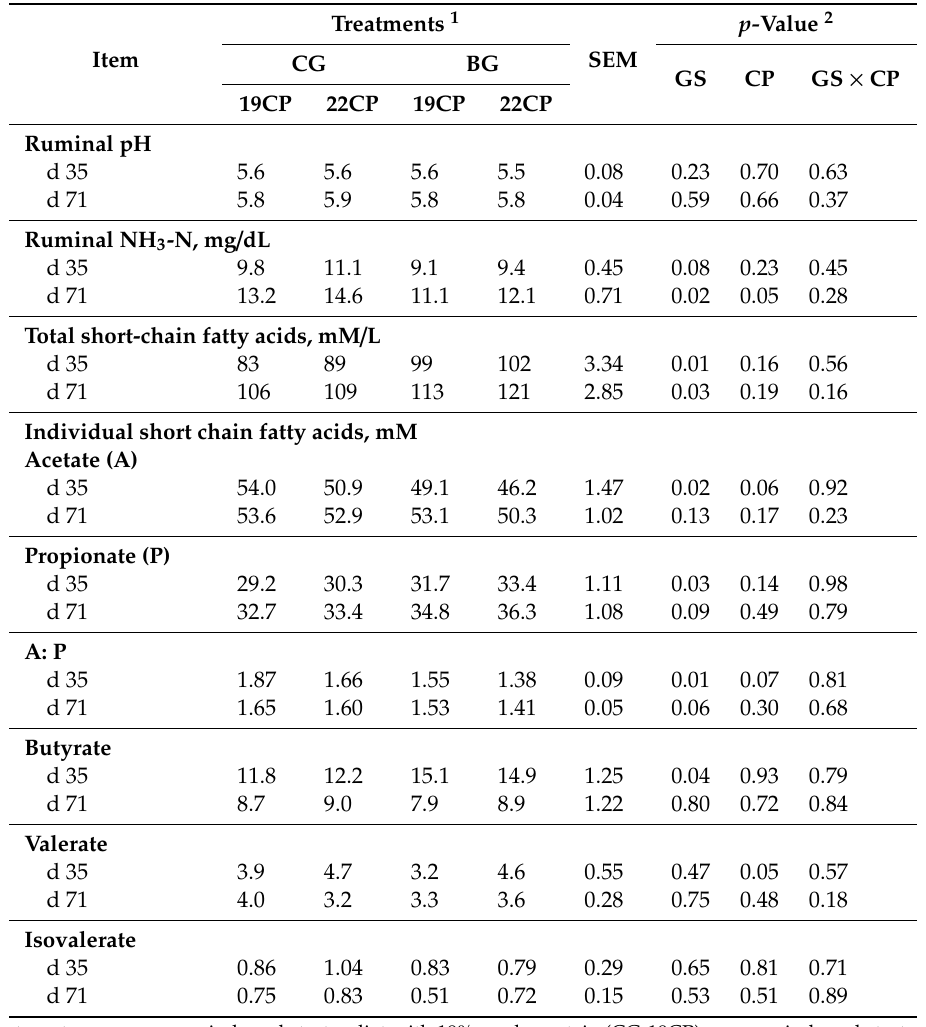
Table 4. Least square means for ruminal metabolism in dairy calves fed di ff erent grain sources (corn grain vs. barley grain) and di ff erent protein levels (19% vs. 22 % of DM) ( n = 10 calves per treatment).